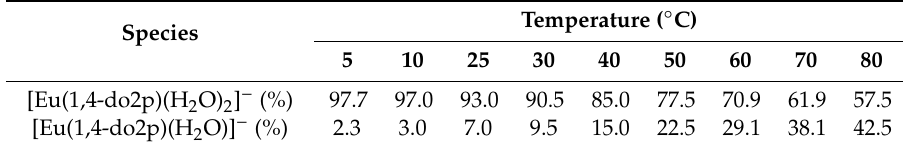
Figure 5. Temperature dependence of 5 D 0 ← 7 F 0 transition in absorption spectra of the Eu(III)– 1,4-H 4 do2p complex (pH 8.5, selected spectra; for all data, see Figure S6). Table 6. Species abundance at di ff erent temperature according to deconvolution of the absorption Table 6. Species abundance at different temperature according to deconvolution of the absorption spectra of the Eu(III)–1,4-H 4 do2p spectra of the Eu(III)–1,4-H 4 do2p complex.